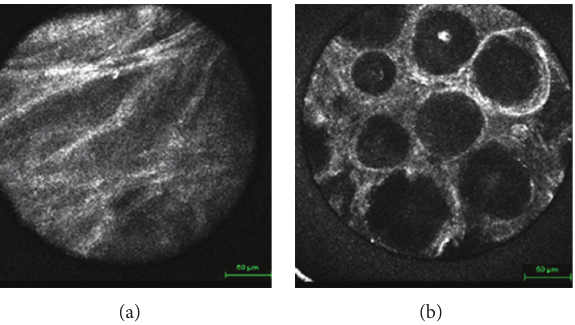
Figure 4: (a) Meningioma. (b) Psammomatous meningioma.